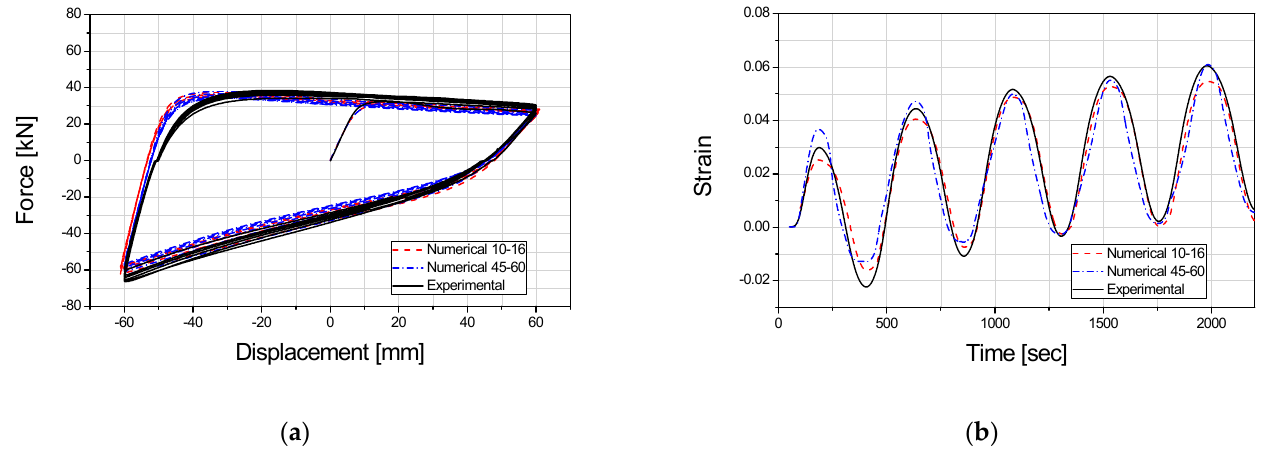
Figure 5. Comparison of the experimental and finite element analysis results: ( a ) comparison of the force–displacement response; ( b ) comparison of the strain response.